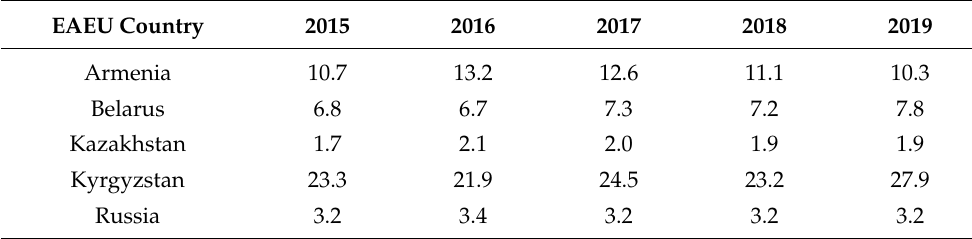
Table 5. Renewable share in final energy consumption (SDG 7.2) *. EAEU Country